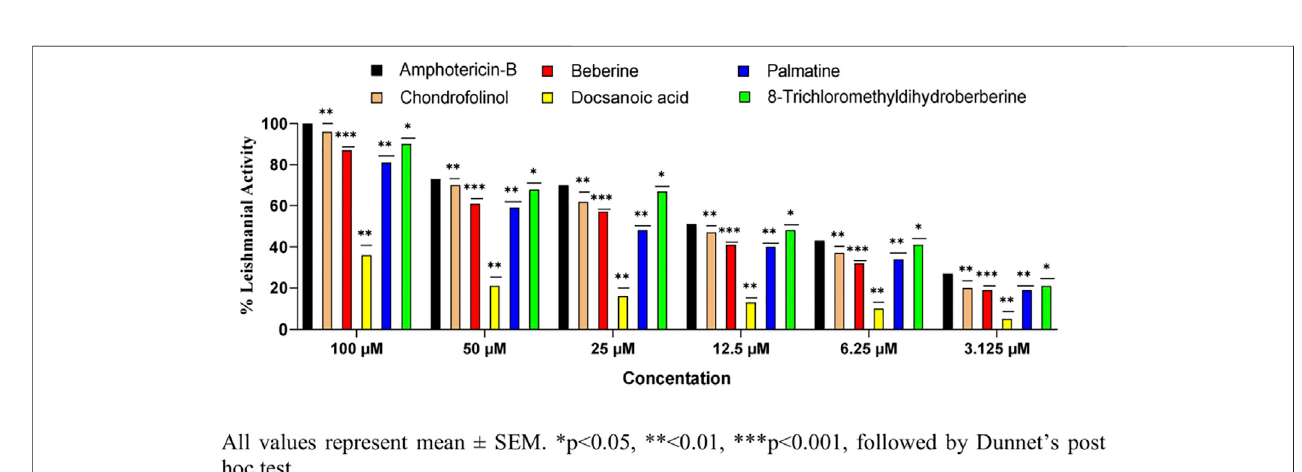
FIGURE 4 | Anti-leishmanial properties of 1 – 5 against Leishmania tropica .